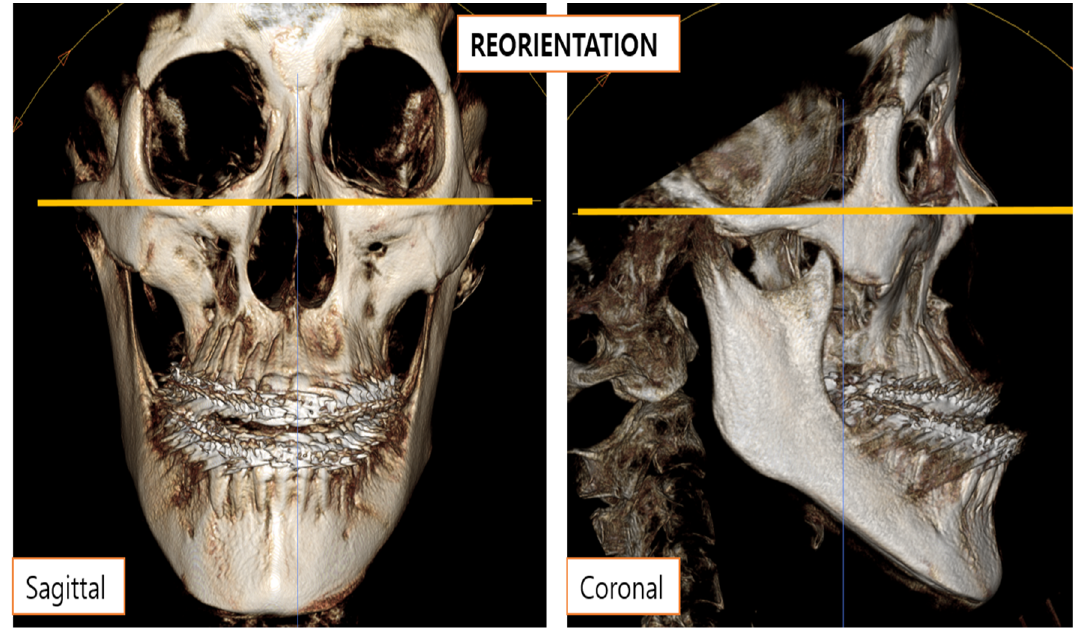
Figure 2. Reorientation of the CBCT according to the Frankfort horizontal plane.